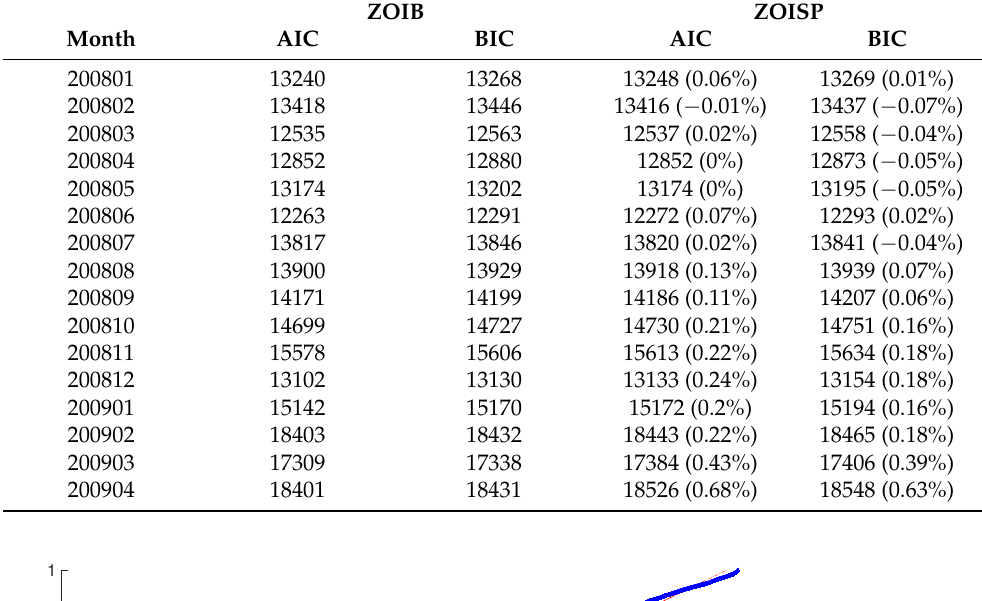
Table 3. Information criteria for the fitted ZOIB and ZOISP distributions.